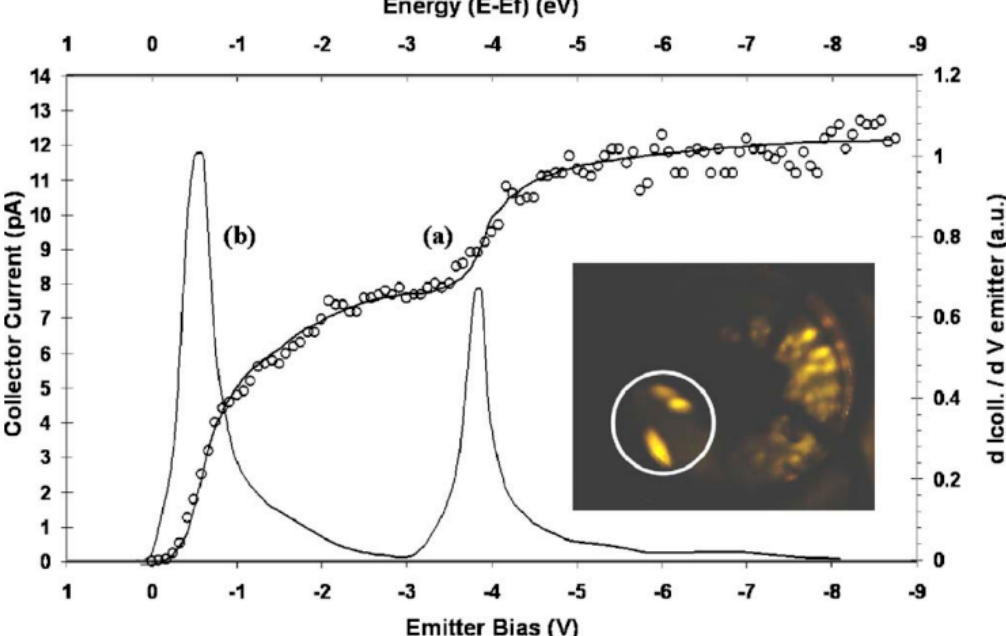
Figure 13. Field emission energy spectra from a ZnO taprapod emitter. ( a ) Collector current versus emitter bias charac- teristic. ( b ) Differentiation of ( a ). Inset is the field emission pattern. Reproduced from [71], with the permission of AIP Pub- lishing, 2007.